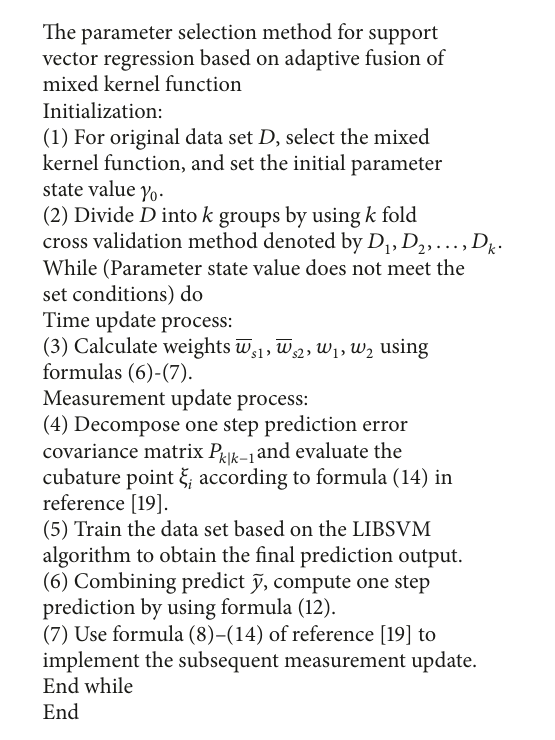
Algorithm 1: The detailed algorithm steps of the parameter selection method for support vector regression based on adaptive fusion of mixed kernel function.